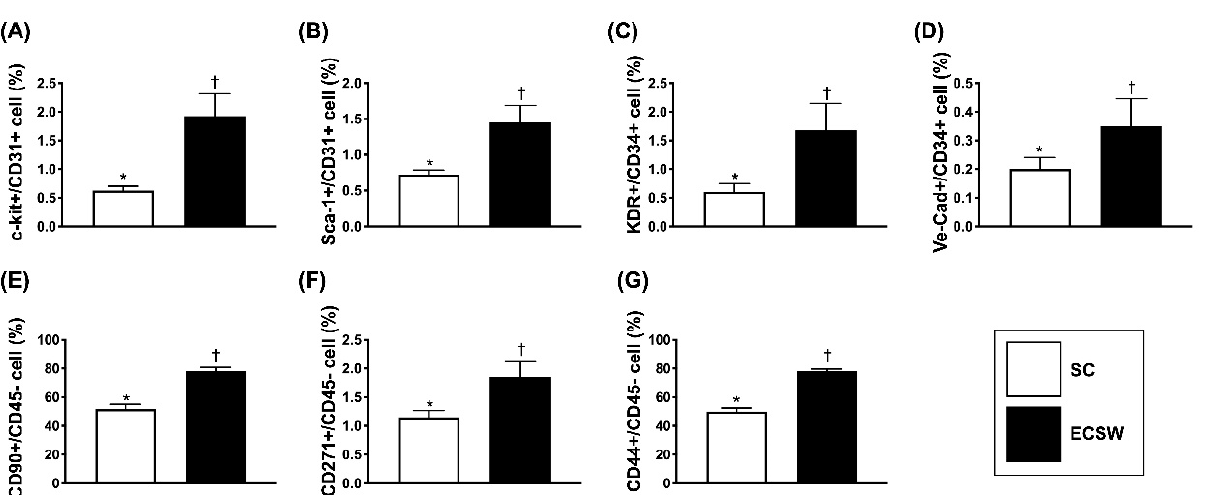
Figure 4. Circulating levels of endothelial progenitor cells (EPCs) and MSCs by 72h after ECSW therapy. ( A ) Analytical result of number of circulating c-kit +/CD133+ cells, * vs. †, p < 0.01. ( B ) Analytical result of number of circulating Sca-1 +/CD31 + cells, * vs. †, p < 0.01. ( C ) Analytical result of number of circulating KDR+/CD34+ cells, * vs. †, p < 0.01. ( D ) Analytical result of number of circulating Ve-Cad+/CD34+ cells, * vs. †, p < 0.01. ( E ) Analytical result of number of circulating CD90+/CD45 − cells, * vs. †, p < 0.01. ( F ) Analytical result of number of circulating CD271+/CD45 − cells, * vs. †, p < 0.01. ( G ) Analytical result of circulating CD44+/CD45 − cells, * vs. †, p < 0.01. Ve-Cad = vascular endothelial cadherin; SC = sham control; mito = mitochondria; ECSW = extracorporeal shock wave.